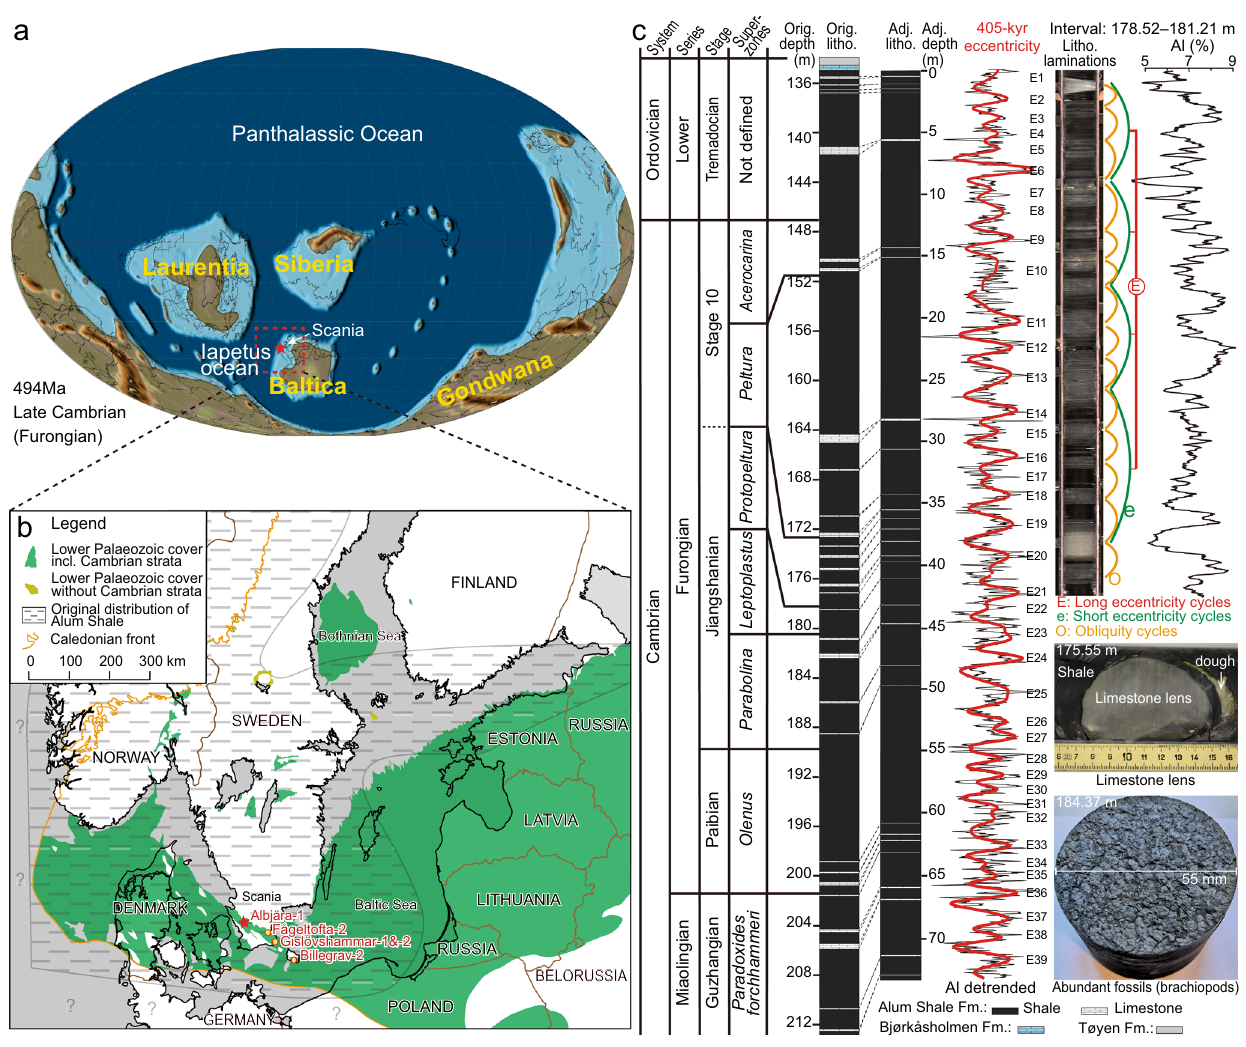
Fig. 1 Summary of relevant geographical and stratigraphic data. a Late Cambrian (494 Ma) global palaeogeography 85 . b Location map showing the original distribution of the Alum Shale Formation in southern Scandinavia and the location of wells referred to (modi fi ed from ref. 30 ). c Biozonation, lithology and cyclostratigraphy of the Furongian interval including strata below and above in the Albjära-1 core, as well as representative core photos of the shale, a limestone lens and a bedding surface covered by fossils. The base of Stage 10 remains to be formally de fi ned (see text for remarks), only the base de fi ned by the FAD of L. americanus is plotted here. The 405-kyr eccentricity cycles in four subsets 0 – 18, 18 – 41, 41 – 55 and 55 – 74 m were extracted using Taner fi lters with centres (cut-offs) of 1.9 (1.3 – 3.3) cycles/m, 2.4 (1.5 – 4.2) cycles/m, 2.3 (1.0 – 5.0) cycles/m, and 1.8 (1.1 – 3.6) cycles/m, respectively. Adjusted depth was obtained by measuring from the Alum Shale Formation top downward after reducing the original limestone thickness to 20%. Lamination cycles are closely tracked by Al concentration variations (the 178.52 – 181.21 m interval is shown as an